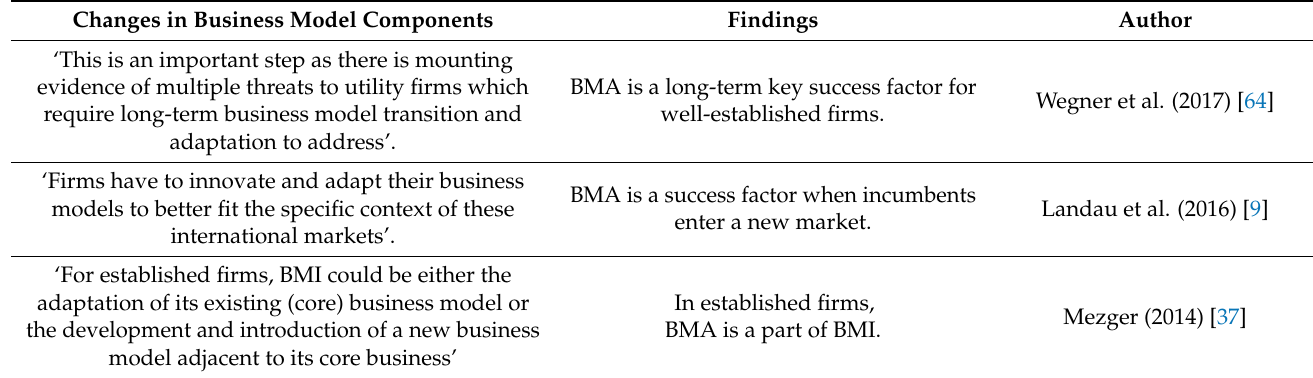
Table 12. Regarding